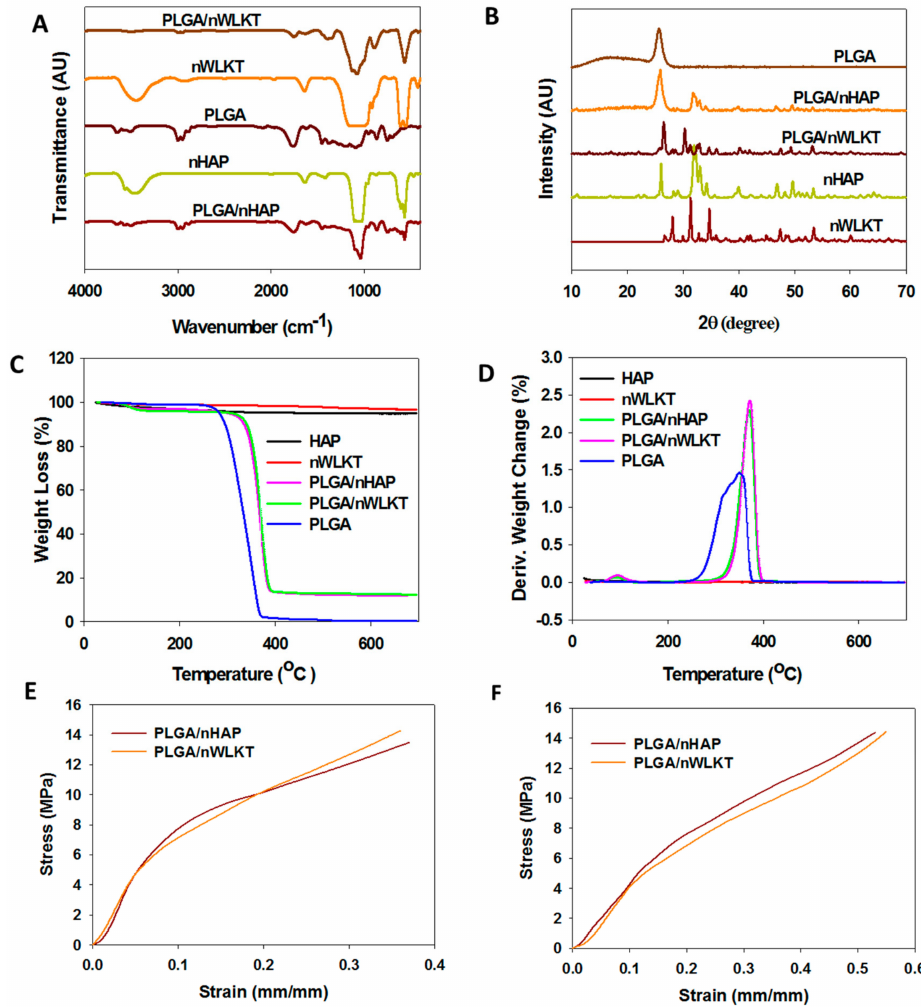
Figure 3. Characterization of nHAP, nWLKT, PLGA, PLGA / nHAP, and PLGA / nWLKT by Fourier-transformed infrared spectroscopy (FTIR) ( A ), X-ray di ff raction (XRD) ( B ), thermogravimetric analysis (TGA) ( C ), and di ff erential thermogravimetry (DTG) ( D ). The stress-strain curves of PLGA / nHAP and PLGA / nWLKT microsphere sca ff old obtained through compressive mechanical testing are shown in ( E ) and ( F ) for dry and wet